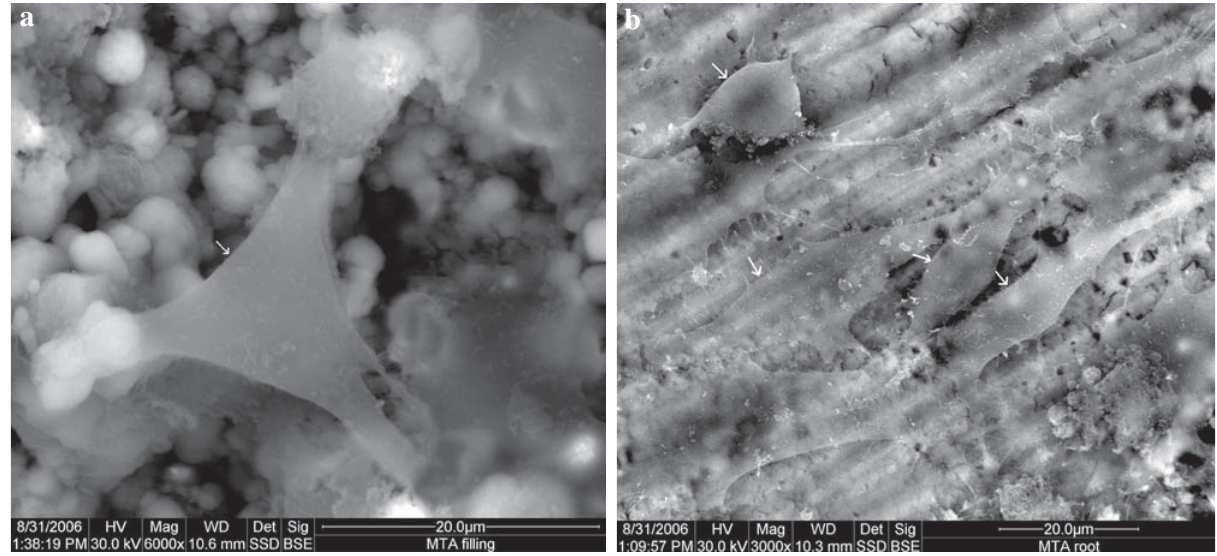
Figure 3 (cid:7)(cid:12)(cid:31)(cid:21)(cid:15)(cid:6)(cid:6)(cid:5)(cid:6)(cid:13)(cid:12)(cid:3)(cid:14)(cid:3)(cid:21)(cid:17)(cid:16)(cid:9)(cid:6)(cid:12)(cid:8)(cid:5)(cid:21)(cid:16)(cid:9)(cid:4)(cid:21)(cid:9)(cid:22)(cid:3)(cid:12)(cid:24)(cid:31)!"(cid:29)(cid:12)(cid:8)(cid:5)(cid:21)(cid:16)(cid:9)(cid:13)(cid:16)(cid:15)(cid:22)(cid:18)(cid:12)(cid:9)(cid:23)(cid:12)"#$%(cid:12)(cid:24)(cid:15)(cid:29)(cid:12)(cid:8)(cid:15)(cid:17)(cid:3)(cid:16)(cid:5)(cid:15)(cid:14)(cid:12)(cid:4)(cid:19)(cid:16)(cid:23)(cid:15)(cid:21)(cid:3)(cid:12)(cid:24)(cid:9)(cid:16)(cid:5)(cid:13)(cid:5)(cid:6)(cid:15)(cid:14)(cid:12)(cid:8)(cid:15)(cid:13)(cid:6)(cid:5)(cid:11)(cid:21)(cid:15)(cid:17)(cid:5)(cid:9)(cid:6)(cid:12)’(cid:26)(cid:27)(cid:27)(cid:27)(cid:28)(cid:29)*(cid:12)(cid:24)/(cid:29)(cid:12)